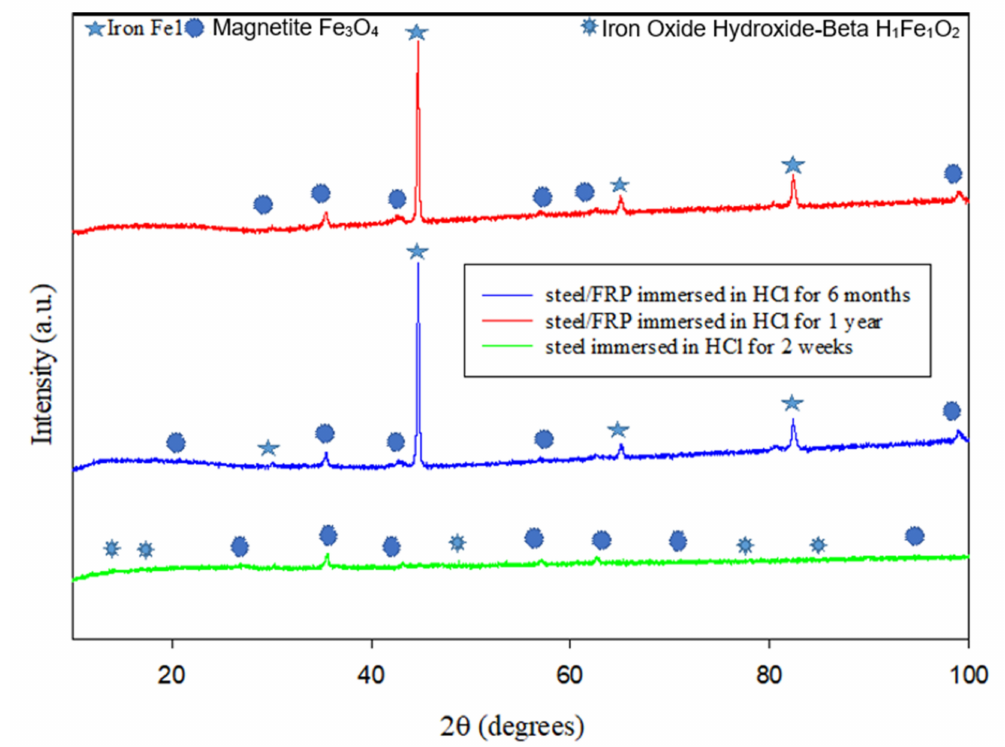
Figure 7. XRD patterns for the steel surfaces after immersion in HCl solution.